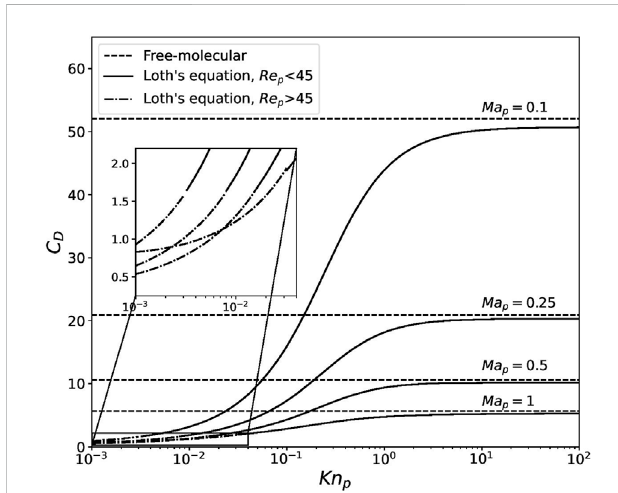
FIGURE 21 Drag coef fi cient VS particle Knudsen number for Loth ’ s equations Loth et al. (2021) and the free-molecular model Bird and Brady (1994) in subsonic fl owconditions. Ma p (cid:1) | (cid:2) v r | / a g and Re p (cid:1) ρ g | (cid:2) v r | d p / μ g ,where (cid:2) v r is the particle-gas relative velocity, a g is the speed of sound, ρ g is the gas mass density, d p is the particle diameter, and μ g is the gas dynamic viscosity Loth et al. (2021). The calculation of the coef fi cient is based on